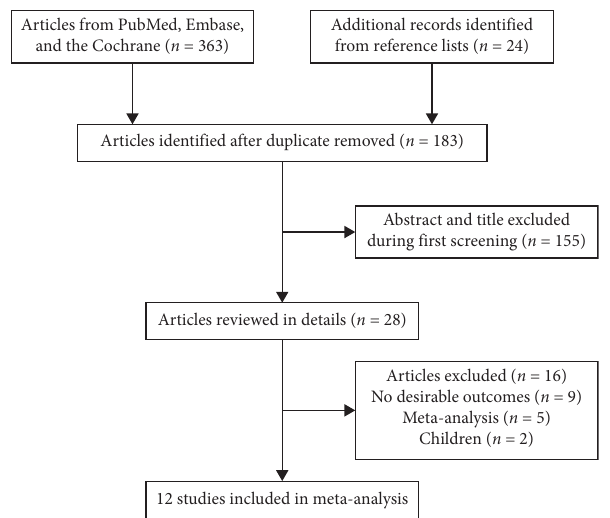
Figure 1: Flow diagram of the literature search and study